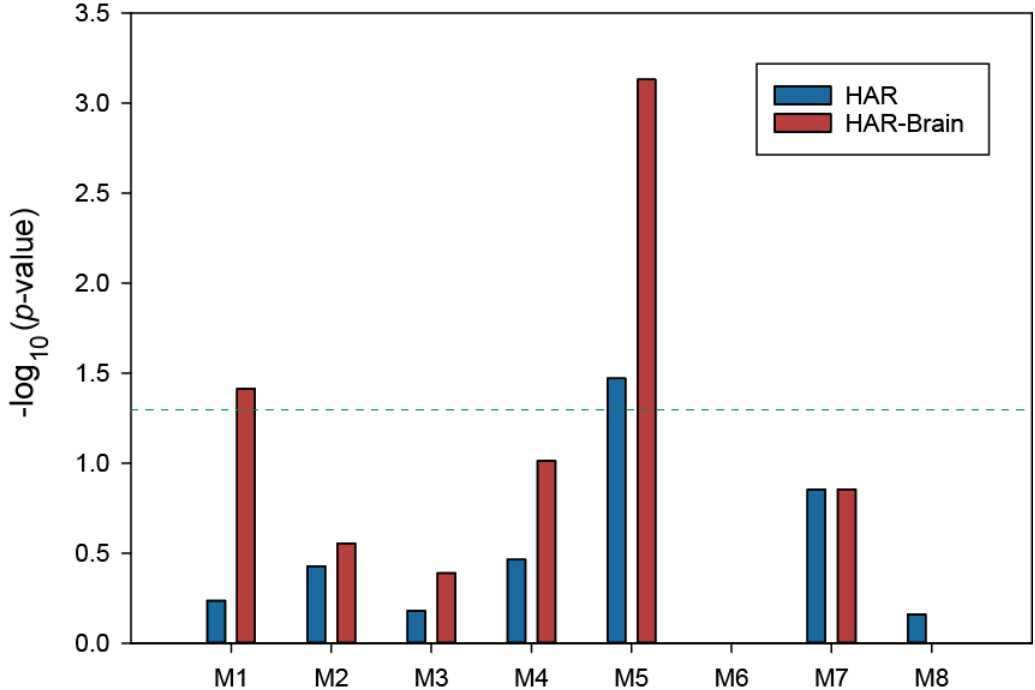
Figure 5. Enrichment of human accelerated region (HAR) and HAR-Brain genes in the delirium-related modules. Overlaps of module genes with HAR and HAR-Brain genes were examined, and the enrichment was tested by using Fisher’s exact test. Results with p -values less than 0.05 were considered statistically significant. The dashed line indicates p = 0.05.